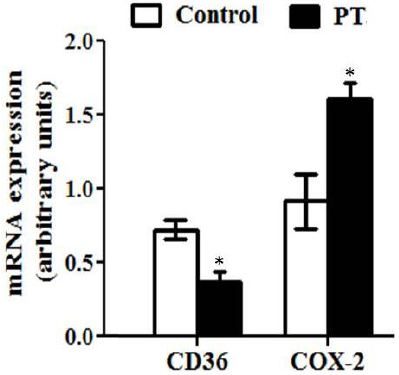
Figure 5. Fatty acid translocase/scavenger receptor cluster of differentiation (CD36) and respiratory electron transport chain complex II (cox-2) gene expression in liver from fa / fa Zucker rats either treated or not with pterostilbene (30 mg/kg body weight/day) for six weeks. Values are means ± SEM ( n = 10). Differences between groups were determined by the Student’s t test. Statistical significance was set at the p < 0.05 level. * p < 0.05.